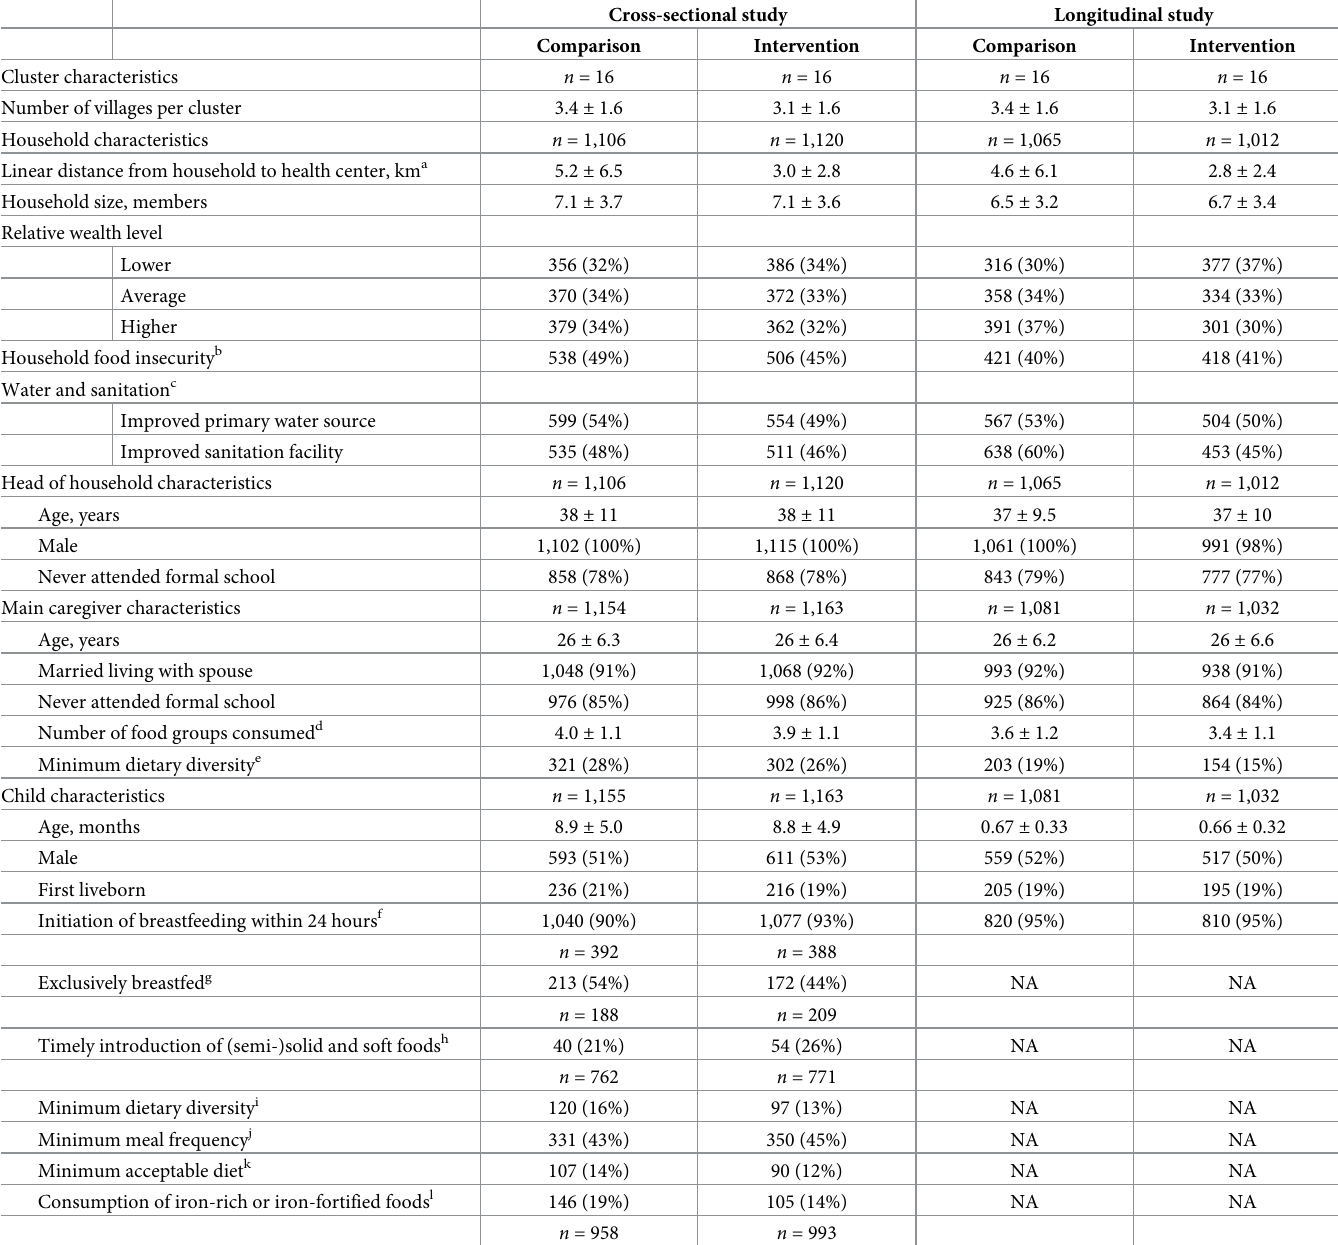
Table 2. Baseline (cross-sectional study) and enrollment (longitudinal study) sample characteristics by study group. Cross-sectional study Longitudinal study Comparison Intervention